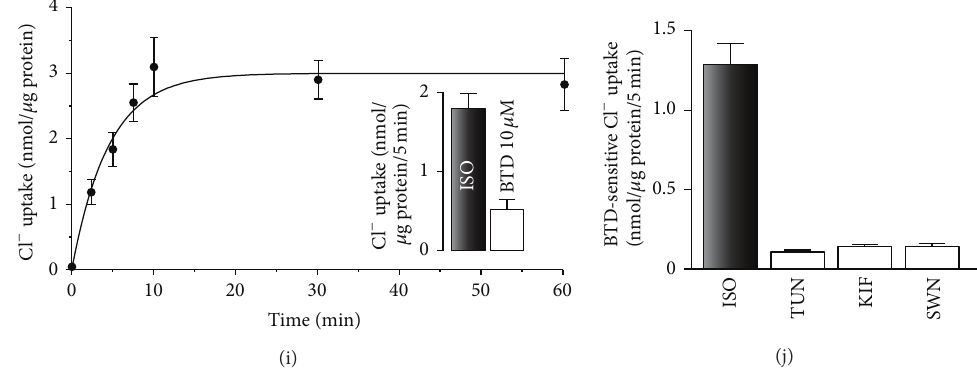
Figure 9: Inhibition of N-glycan processing or complex N-glycosylation does not preclude NKCC1 plasma membrane localization but impairs its function. ((a) and (d)) Shown are representative immunoblots experiments showing total endogenous expression levels of NKCC1 a in COS7 cells incubated with (DMSO, control) 5–10 𝜇 g/mL of kifunensine (KIF, (a)) or 1-2 𝜇 g/mL swainsonine (SWN, (d)) for 16h. Note that the expected bands of NKCC1 a , that is, ∼ 130 kDa and ∼ 170kDa, are detected in control and treated cells whereas additional ckNKCC1-immunoreactive bands centered at ∼ 150 kDa are observed only in protein extracts from KIF/SWN-treated cells. As loading control, immunoblots were developed using antibodies directed against 𝛽 -actin. ((b) and (e)) Shown are representative immunoblots demonstrating expression of EndoH-sensitive hybrid-type N-glycosylated NKCC1 a in total protein extracts of COS7 cells treated for 16hs with KIF (10 𝜇 g/mL) or SWN (2 𝜇 g/mL). Note the absence of immunoreactive bands corresponding to NKCC1 a ∼ 170kDa in cell extracts obtained from KIF/SWN-treated cells. ((c) and (f)) Shown are representative immunoblots demonstrating expression of NKCC1 a in biotinylated plasma membrane fractions of COS7 cells grown under control conditions or treated for 16 h with KIF or SWN. Protein expression of the cytosolic GAPDH was used to assess the purity of the plasma membrane fractions. (g) Densitometry scanning representing the total cellular N-glycan types of NKCC1 in COS7 cells control or treated for 16h with KIF (10 𝜇 g/mL) or SWN (2 𝜇 g/mL). (h) Representative densitometry scanning of NKCC1 immunoblots of plasma membrane fractions obtained from COS7 cells control or treated for 16h with KIF (10 𝜇 g/mL) or SWN (2 𝜇 g/mL). (i) Cl − uptake into COS7 cells depleted of endogenous Cl − as a function of time (0–60min). Uptake is represented as nmol/ 𝜇 g protein [mean ± SEM ( 𝑛 = 6 )]. Inset: mean Cl − uptake [nmol/ 𝜇 g protein/5min ± SEM ( 𝑛 = 5 )] obtained under isotonic conditions (ISO, black bar) or in the presence of BTD 10 𝜇 M (ISO + BTD, white bar). (j) Impact of TUN (2 𝜇 g/mL), KIF (10 𝜇 g/mL), or SWN (1 𝜇 g/mL) treatment (16hs) on the BTD-sensitive component of Cl − uptake into COS7 cells. Results are expressed as nmol/ 𝜇 g protein/5min ± SEM ( 𝑛 = 3